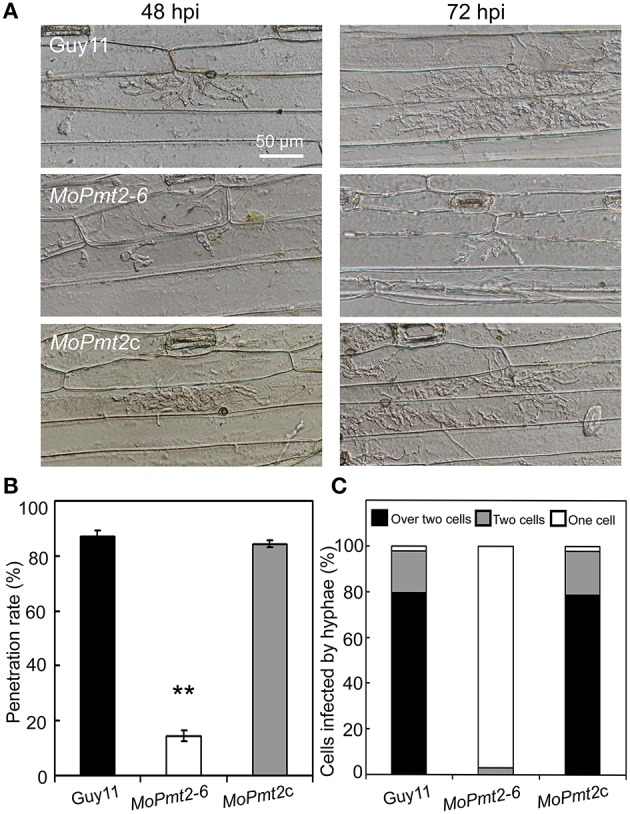
The deletion of MoPmt2 results in impaired appressorium penetration. (A) The MoPmt2 mutants are defective on appressorium-mediated penetration. The MoPmt2 mutants exhibited penetration defects on barley leaves after 48 and 72 h, respectively, in contrast with control strains. Scale bar = 50 μm. (B) Statistical analysis of appressorium penetrated in host cells. The appressoria that penetrated into barley epidermal cells were counted at 48 hpi, and the data were statistically analyzed. Asterisks indicate significant differences among strains. Error bar represents standard deviation. (C) Quantification of hyphae infection on barley epidermal cells. The percentage of infected cells occupied by infectious hyphae of tested strains at 72 hpi were measured and statistically analyzed.